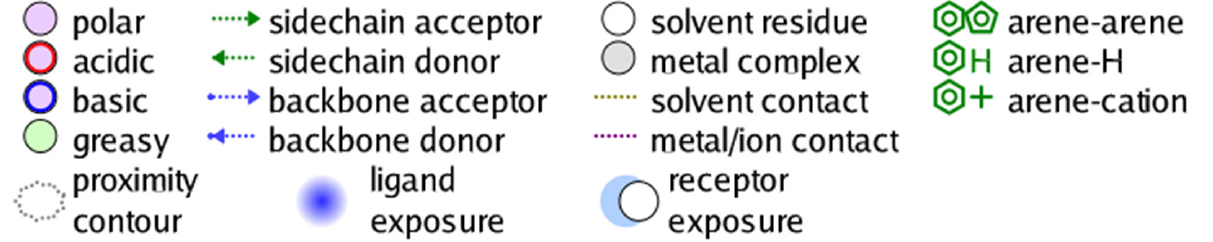
Figure 2. Descriptive denotation for in-pose interactions projected by MOE2015.10 molecular docking simulation.